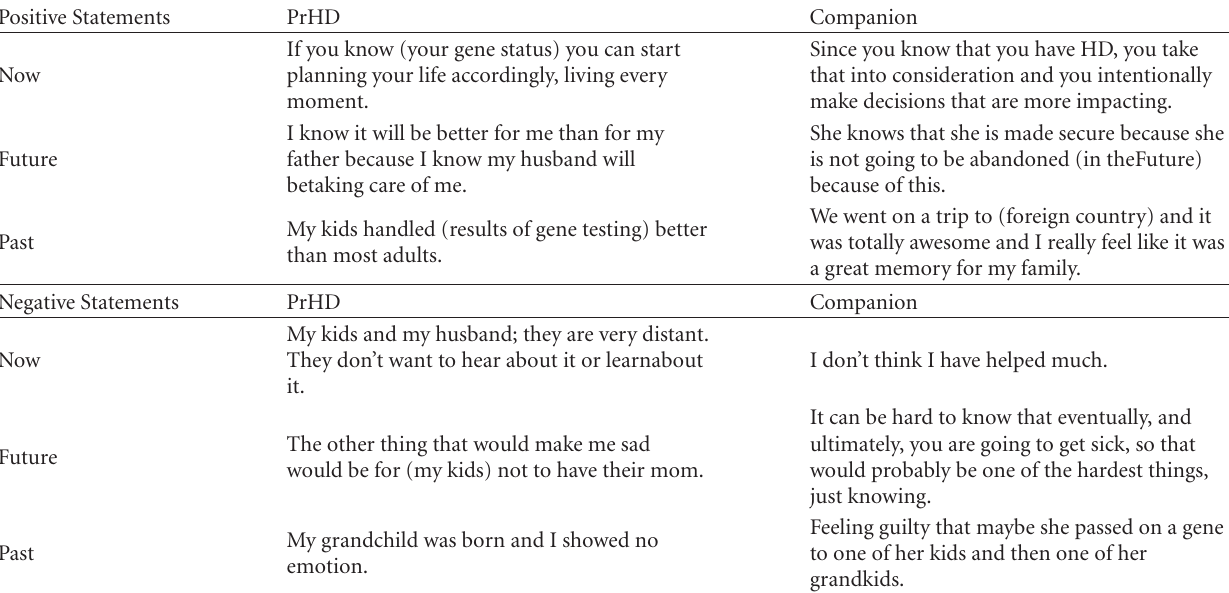
Table 5: Sample positive and negative QOL statements by time